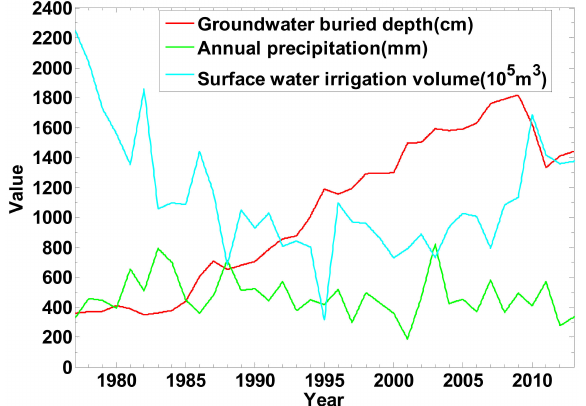
Figure 2. Graph of the development of the groundwater buried depth, annual precipitation, and surface water irrigation volume over time.